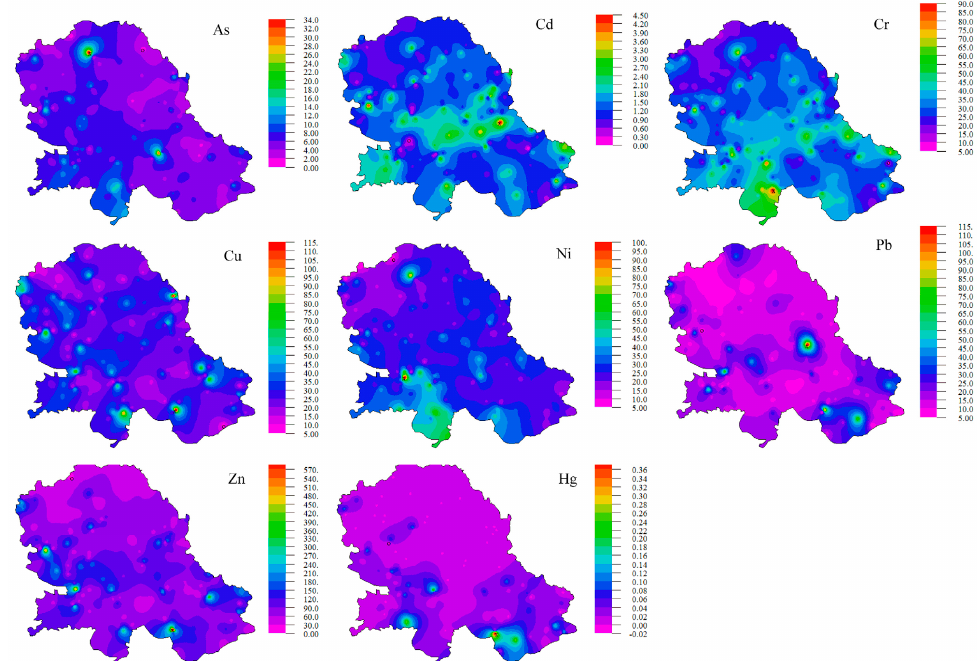
Figure 2. Geographical distribution of HM concentrations in soil samples.